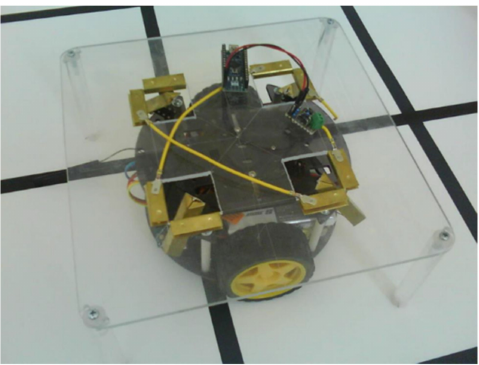
Figure 2. Interconnection of a custom Mobile Robotic System and an empty modular platform.